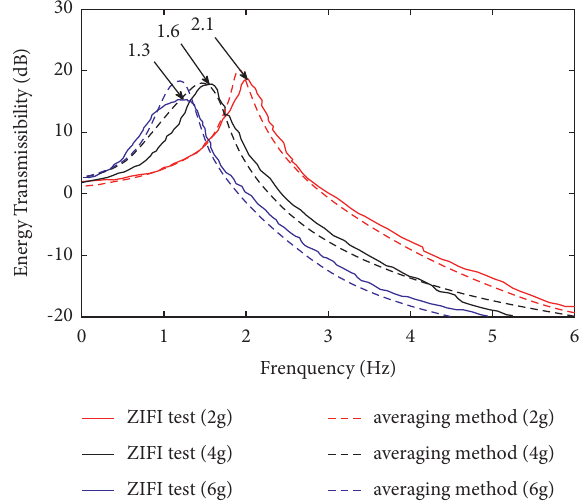
Figure 10: Energy transmissibility curves of the ZIFI with different material mass.